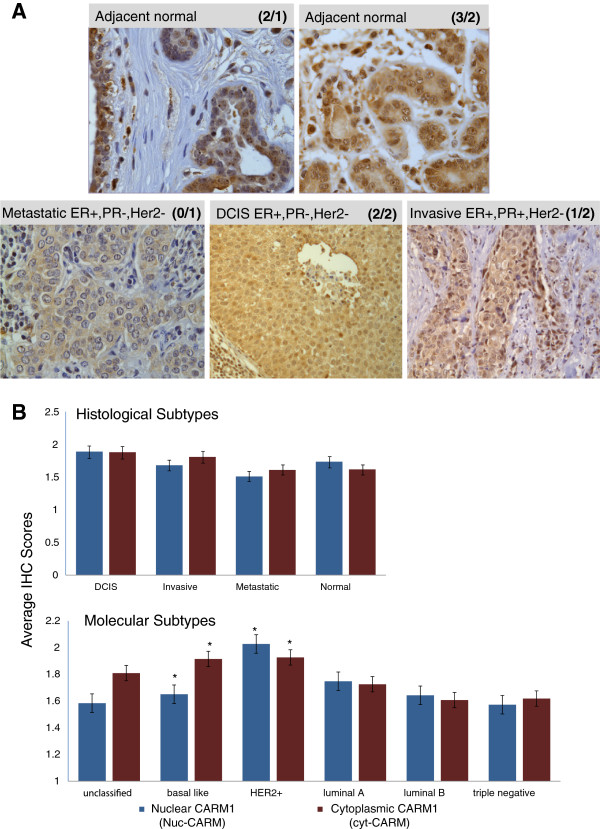
CARM1 expression and sub-cellular localization of across molecular and histological tumor subtypes. A. Representative CARM1 IHC stains for Adjacent-normal (top row) and tumor (bottom row) tissue cores. There is a diverse range of both cytoplasmic and nuclear expression levels for each pathological and histological subtype. The specific histological subtype and nuclear receptor status are indicated on respective images. The CARM1 nuclear/cytoplasmic scores are indicated in parentheses (e.g. (3/2) = nuclear score of 3 and cytoplasmic score of 2). B. Nuclear and Cytoplasmic CARM1 expression tumor score averages, grouped by histological tumor types (top) and molecular tumor subtypes (bottom). Histological subtypes appear to show very little variation in CARM1 expression, with small variations in localization in the invasive and metastatic tumor categories. Normal tissue indicates CARM1 is usually highest in the nucleus. For the molecular subtypes, there is a wide range of variation among the categories. HER2+ tumors have the highest relative expression of CARM1, while basal-like subtypes have the most divergent localization between nucleus and cytoplasm, with the majority of the protein residing in the cytoplasm, contrary to what is seen in normal tissues overall. Asterisks denote findings that were statistically significant and are outlined in Table 1. Error bars are shown to denote Standard Deviation(1).